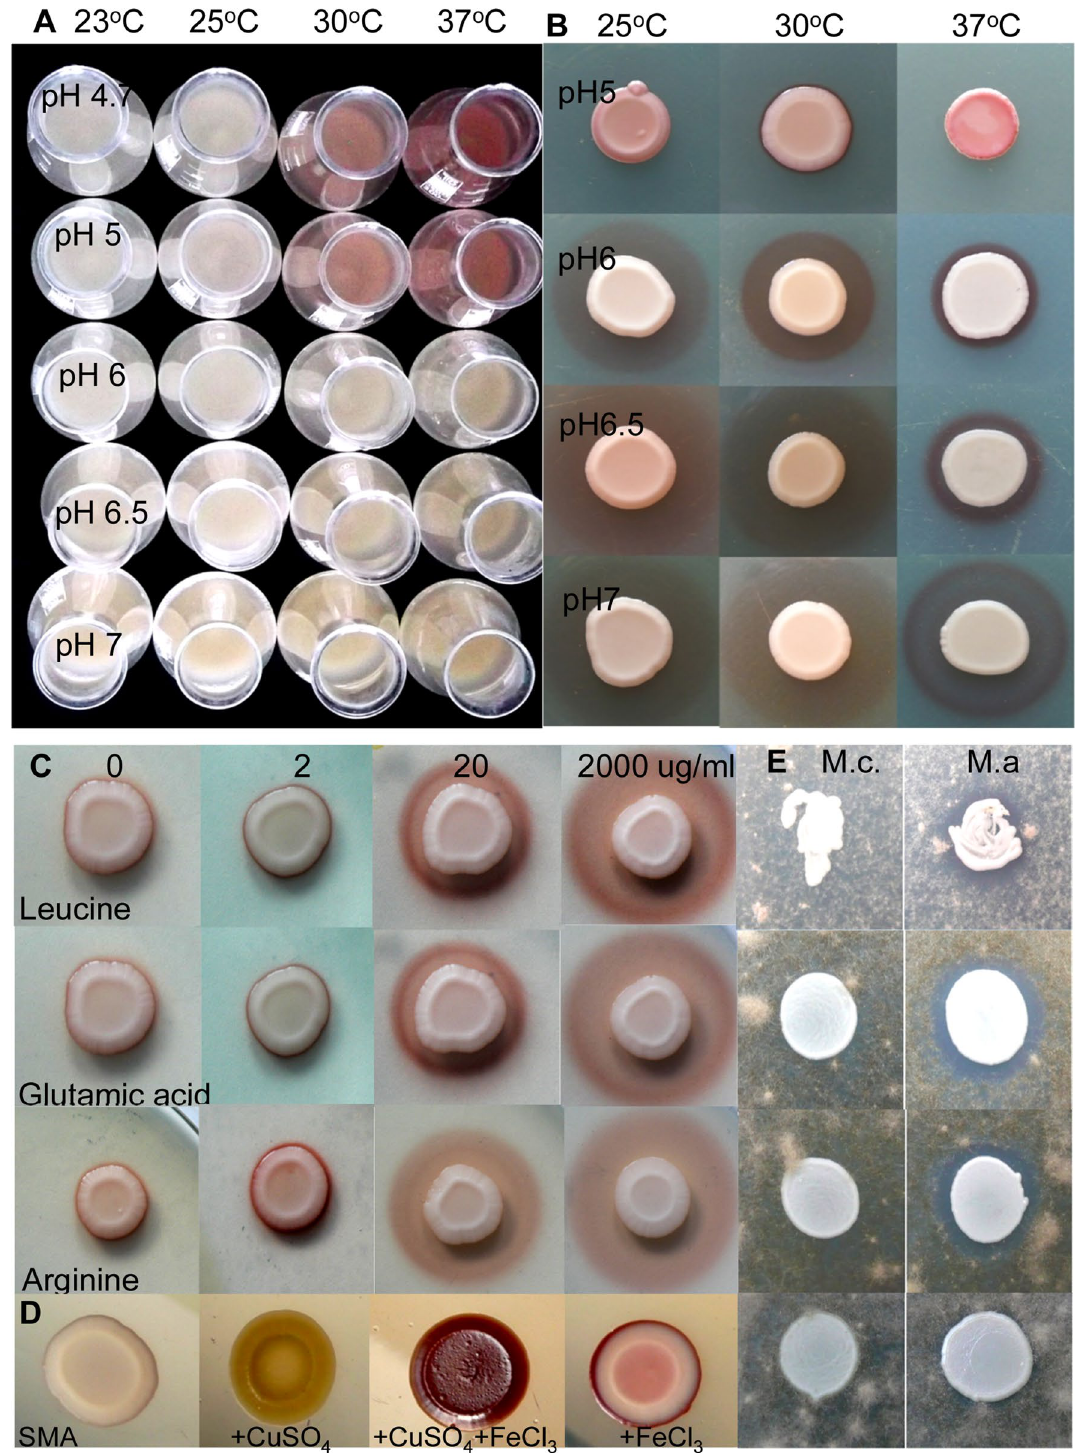
Figure 4. Colour intensity and localisation of the red pigment produced by M. andauensis were influenced by culture factors. Lower pH and higher temperature resulted in darker red pigment in liquid medium ( A ) (PDB liquid medium + 0.01 mg/ml FeCl 3 , which were supplemented with 250 µl FeCl 3 (from 10 mg/ml stock solution) on the 2nd and 3rd days). The cultures were incubated on a shaker for 3 days. The size of the pigmented area was larger at higher pH on PDA (PDB solidified with 1.5% agar and supplemented with 0.01 mg/ml FeCl 3 ) ( B ). The presence of amino acids increased pigment production ( C ). (PDA + 0.005 mg/ml FeCl 3 , pH7 after 6 days, incubated at 25 °C. (SMA medium gave a similar result). ( D ) The addition of copper sulphate allowed budding and pigment production to take place. (SMA was supplemented with FeCl 3, or Cu SO 4 or FeCl 3 plus CuSO 4 ). ( E ) Growth of B. cinerea in the presence of M. andauensis on SMA and SMA supplemented with different amount of CuSO 4 (from top to bottom: SMA, SMA + 0.0005, 0.005, and 0.05 mg/ml CuSO 4 ). The plates were incubated for 5 days at 25 °C. Mc . : Metschnikowia crysoperlea , Ma: Metschnikowia andauensis. B. cinerea was used as